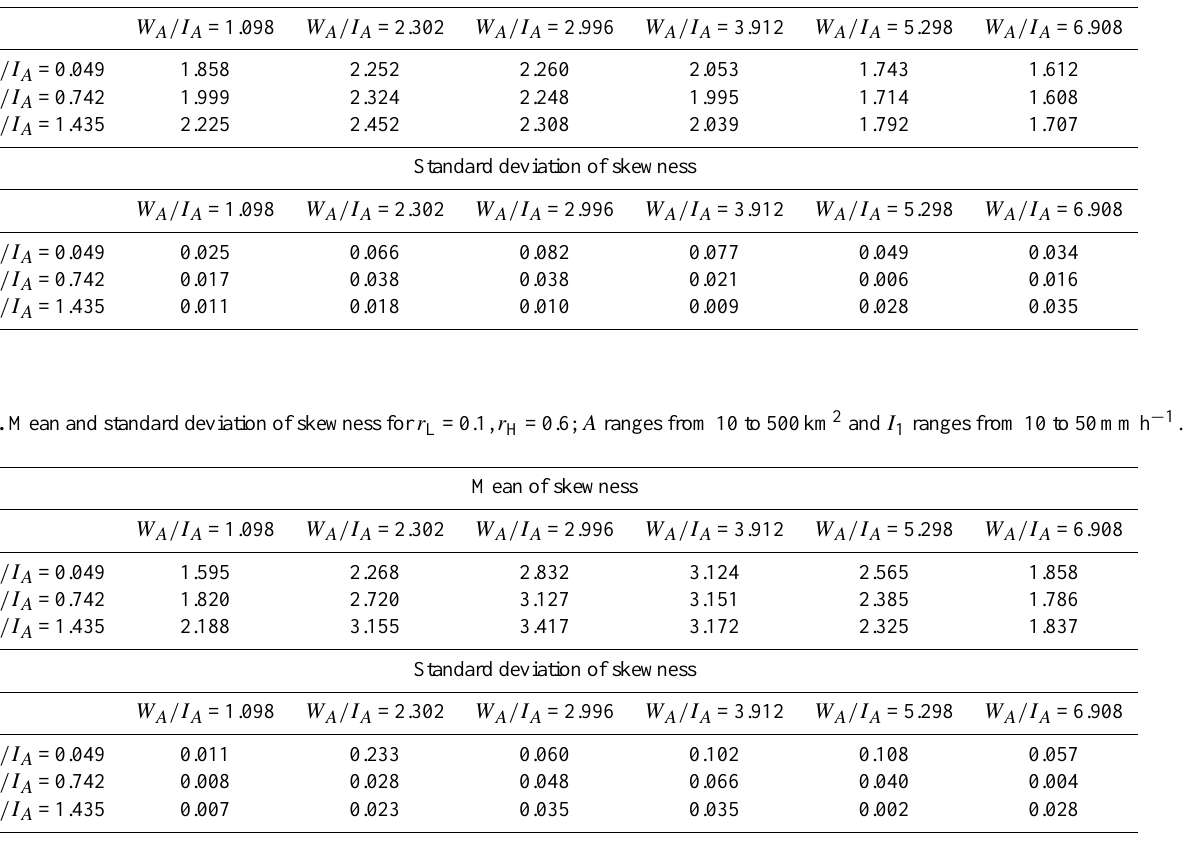
Table 5. Mean and standard deviation of skewness for r L =0.1, r H =0.3; A ranges from 10 to 500km 2 and I 1 ranges from 10 to 50mmh − 1 . Mean of skewness